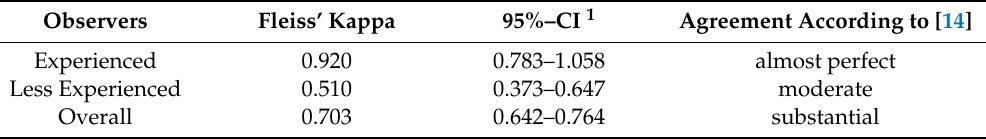
Table 3. Interobserver agreement concerning the identification of PVC-positive